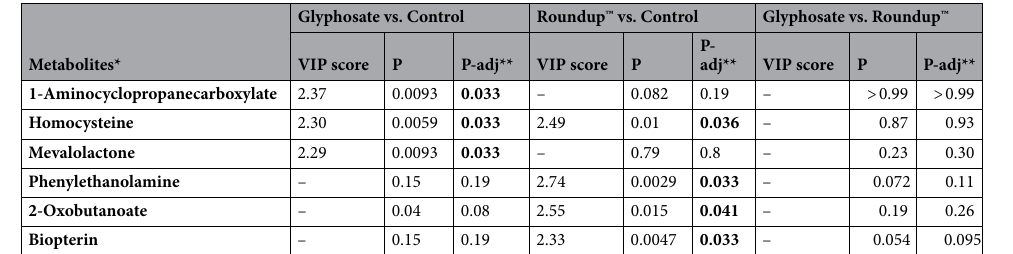
Table 2. The VIP score and fold change of metabolites significantly differentially measured between exposure groups in female pups.